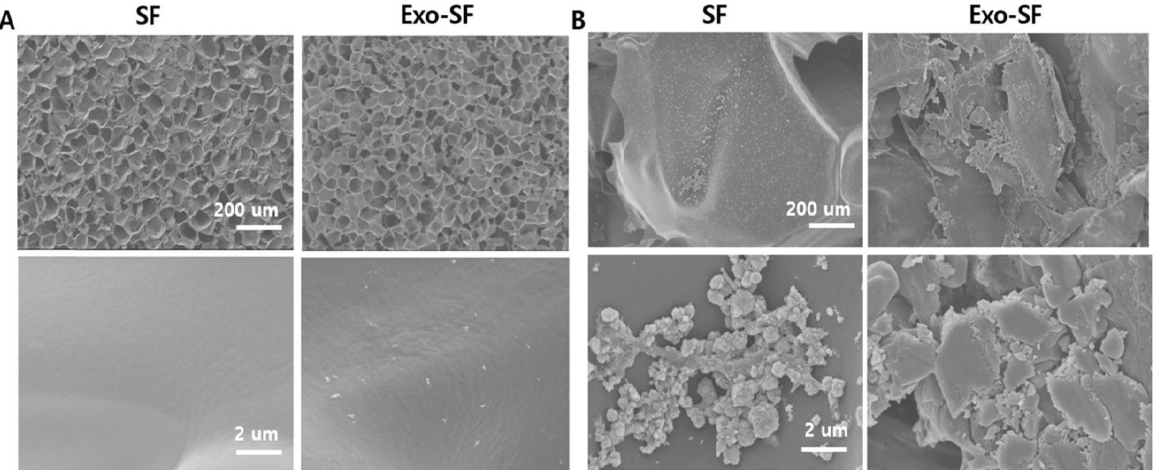
Figure 2. In vitro studies of silk fibroin (SF) and stem cell exosome (Exo)-embedded scaffolds. ( A ) Scanning electron microscope images of bare SF and Exo-SF scaffold surfaces. ( B ) Morphology of human bone marrow-derived mesenchymal stem cells cultured on SF and Exo-SF scaffolds for 2 weeks. Reprinted with permission from Kyung Kim, D.; Lee, S.; Kim, M.; Jeong, Y.; Lee, S. (2021). Copyright 2021 Chemical Engineering Journal, Elsevier [98].